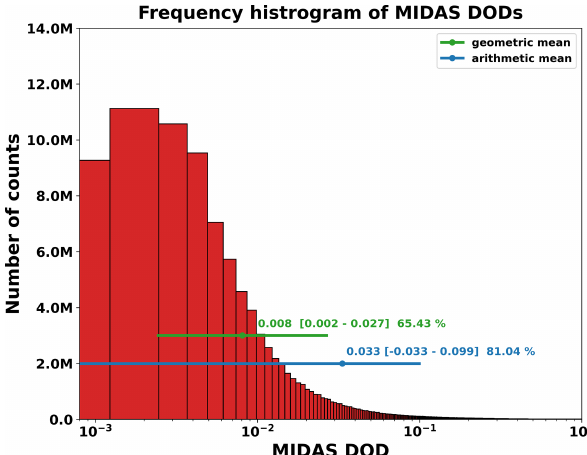
Figure 1. Frequency histogram of MIDAS DODs reported at 1 ◦ × 1 ◦ spatial resolution over the period 2003–2017. The computed geo- metric mean (green) and arithmetic mean (blue) are given along with ranges corresponding to the geometric mean / geometric stan- dard deviation and geometric mean × geometric standard deviation for the geometric mean and ± standard deviation for the arithmetic